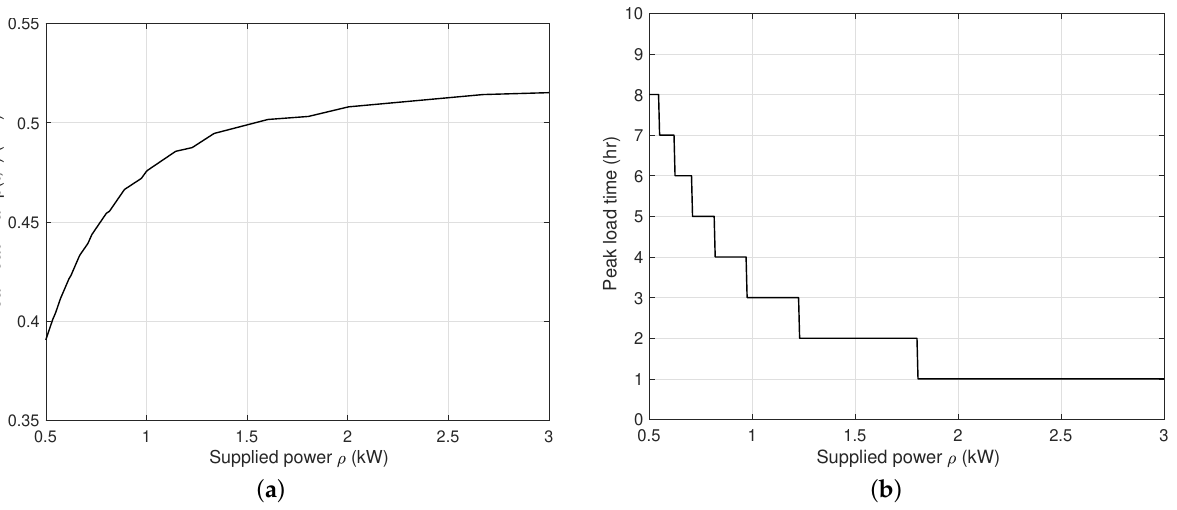
Figure 9. Peak load and time with respect to the charging mean power ( α = 5.2 km/kWh, η = 0.95, and x = 39.6 km). ( a ) Peak load max t p ( t , x ) with respect to ¯ ρ . ( b ) Peak load time argmax t p ( t , x ) with respect to ¯ ρ .